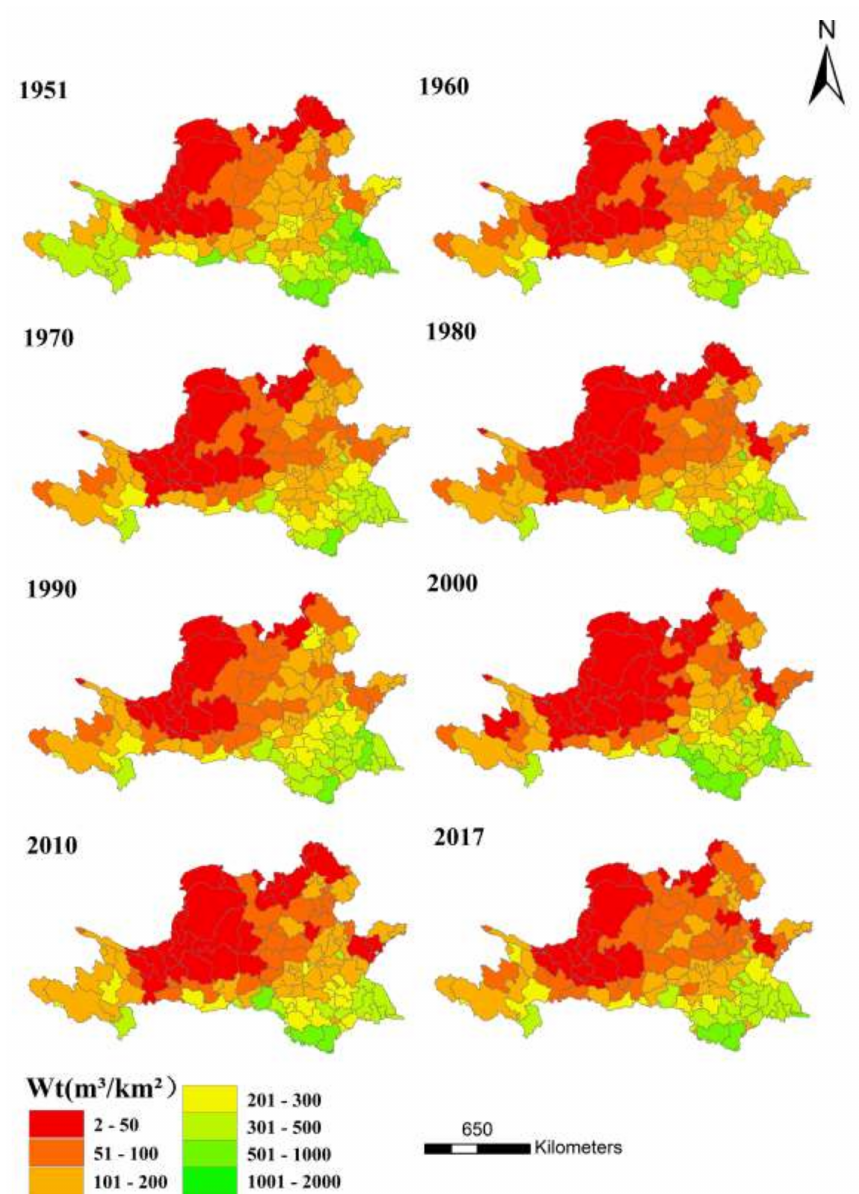
Figure 6. The spatial distribution of the total WLN matching indexes in the Huang-Huai-Hai River Basin during